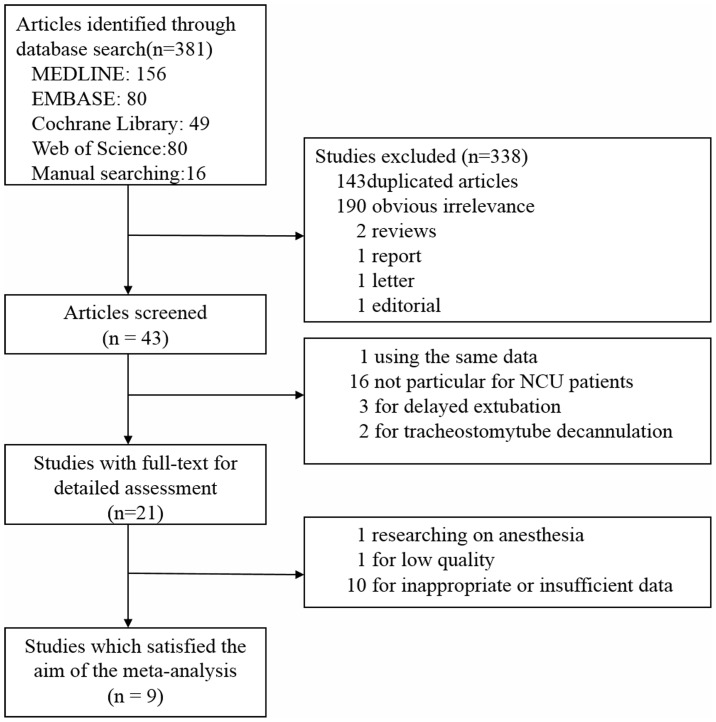
Flow chart illustrating the process of identifying relevant studies.